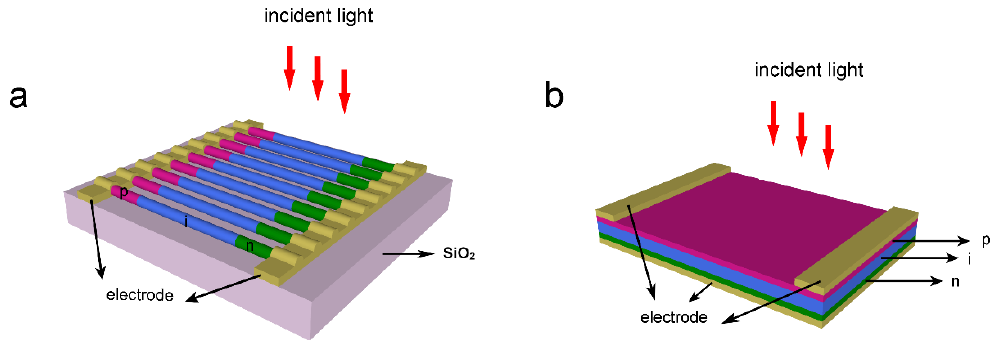
Figure 1. Schematic diagram of ( a ) the horizontally aligned nanowire array (HNA) structure and ( b ) the thin-film counterpart.